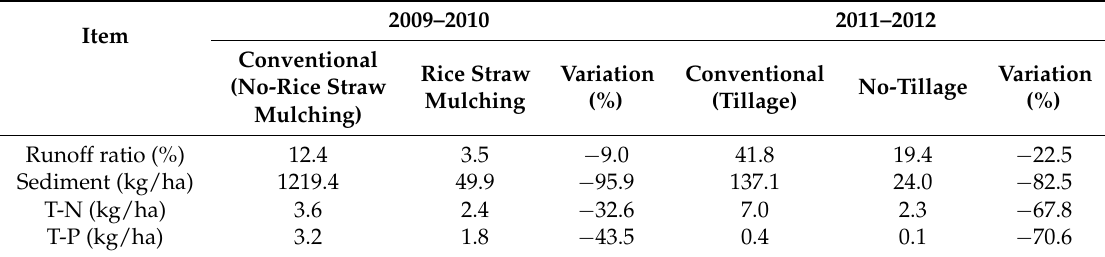
Table 3. Summary of the field experiment results under rice straw mulching and no-tillage conditions.